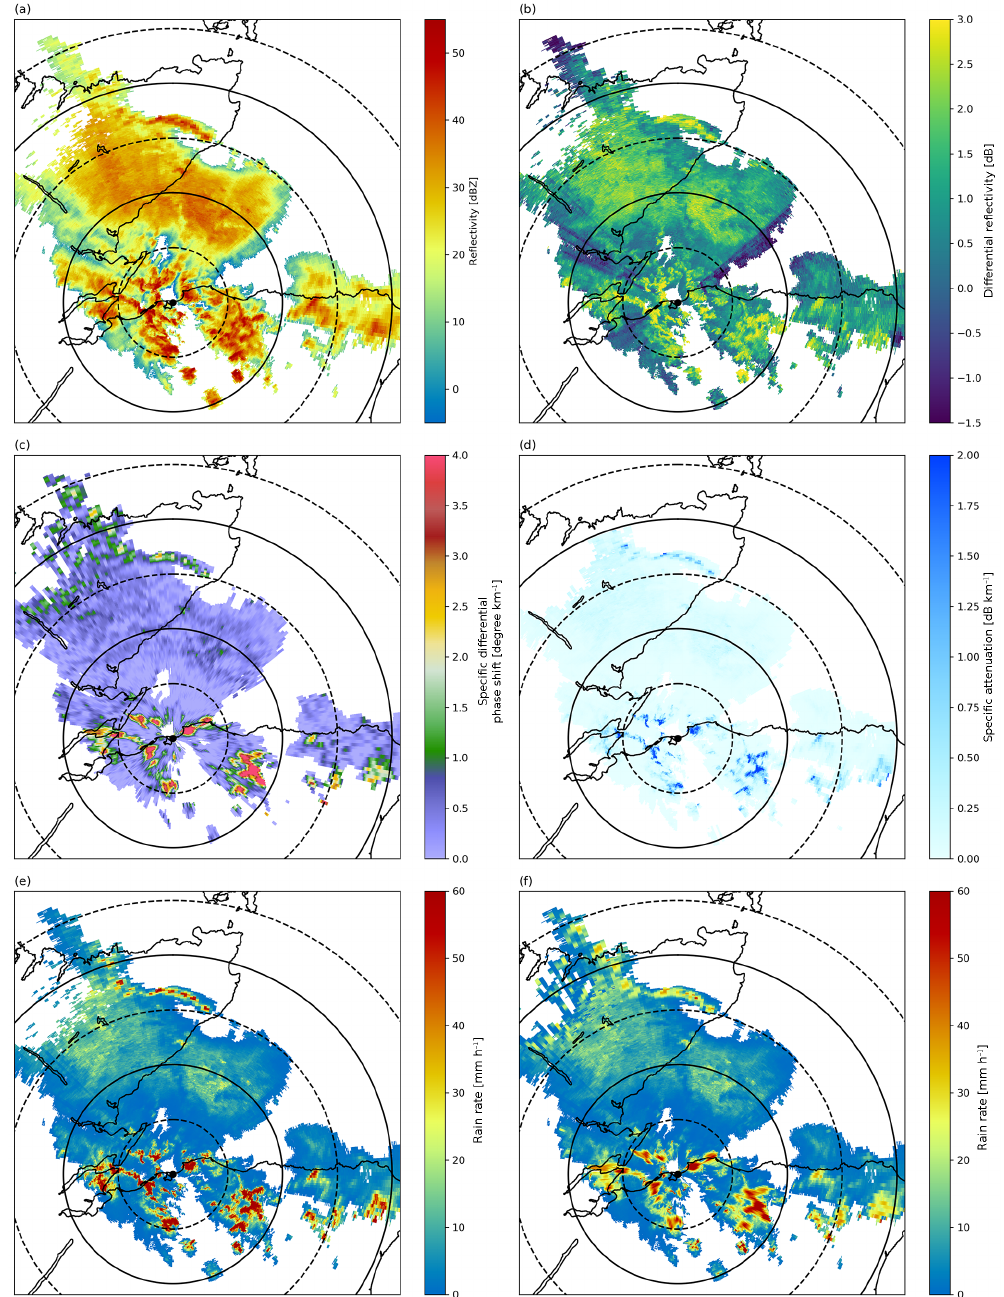
Figure 7. Observations and derived rainfall rates from the RAINS campaign on 20 July 2016 at 04:09UTC at 1.5 ◦ elevation: NXPol is located at the black dot and range rings are drawn every 25km. (a) Calibrated, corrected and filtered Z H classified as precipitation echoes; (b) , (c) and (d) calibrated, corrected and filtered Z DR , K DP , and A H , (e) rainfall rate calculated using the Marshall–Palmer relation ( R(Z) = aZ b , with a = 200 and b = 1 . 6) and (f) rainfall rates calculated using R(Z H ,K DP )